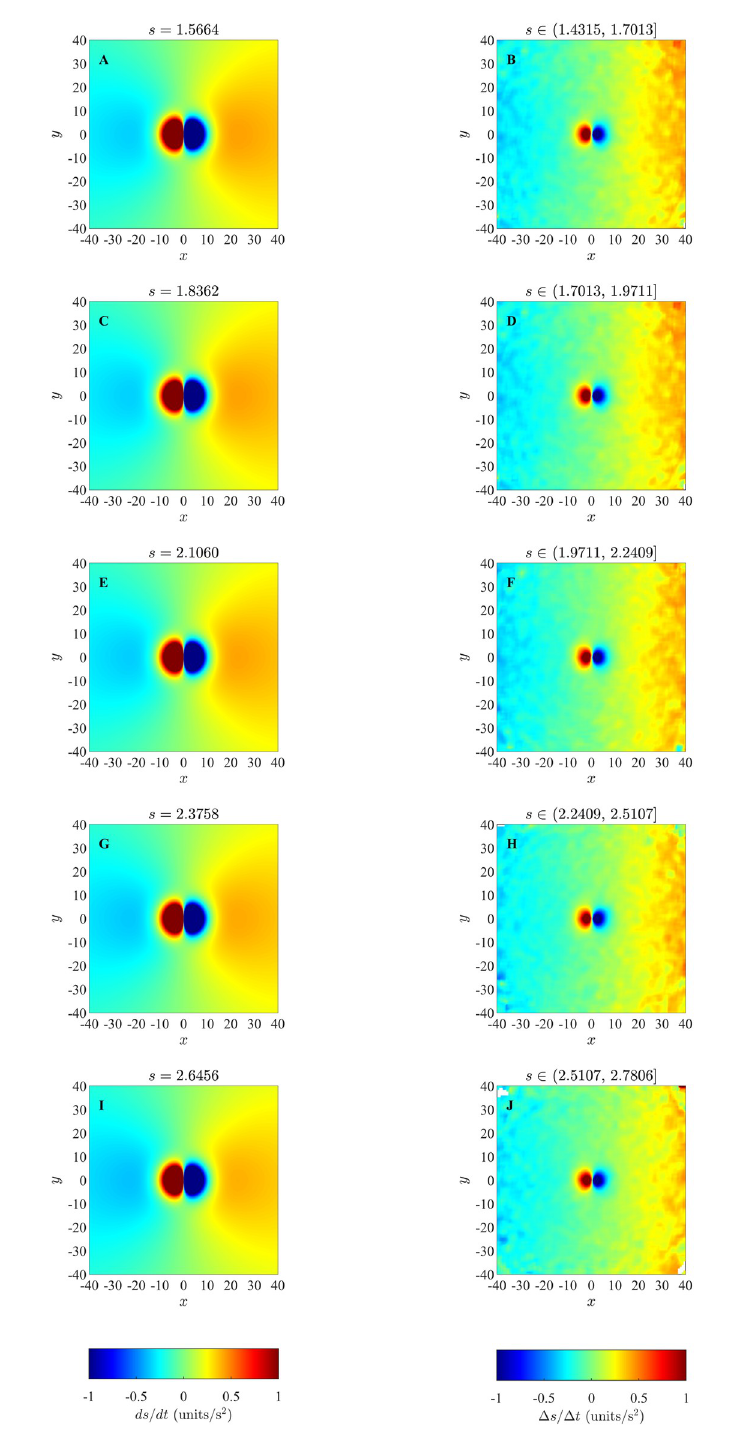
Fig 10. Left column: analytical pairwise changes in speed as prescribed by the ODE model (equation (S3.18)) for groups that form swarms (item (b) from Table 3). Right column: results obtained via the averaging method. Note that unlike changes in direction, changes in speed do not vary as a function of the speed of the focal individual, and thus there is no variation in the plots in the left column, and we expect little variation between the plots in the right column. In each of the plots, the focal individual is located at the origin and moving right along the positive x -axis. The focal individual increases its speed when its partners occupy redder regions in the graphs, and decreases its speed when its